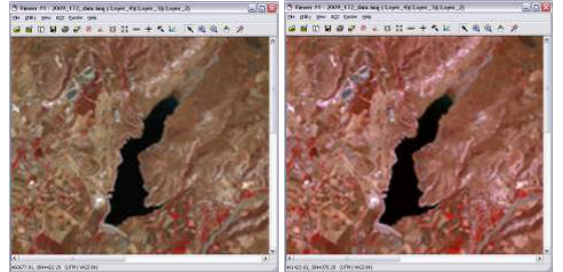
Figure 1. Landsat image before (left) and after (right) the atmospheric correction (from Agapiou et al. 2011b)